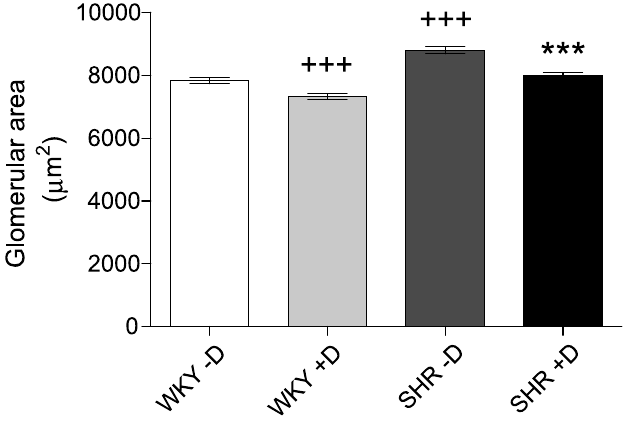
FIGURE 3 - Effect of D- a -tocopherol on glomerular area. Error bars indicate SEM. *** p < 0.001 compared to SHR without D- a -Tocopherol, and +++ p < 0.001 compared to WKY without D- a -Tocopherol. (ANOVA followed by the Bonferroni